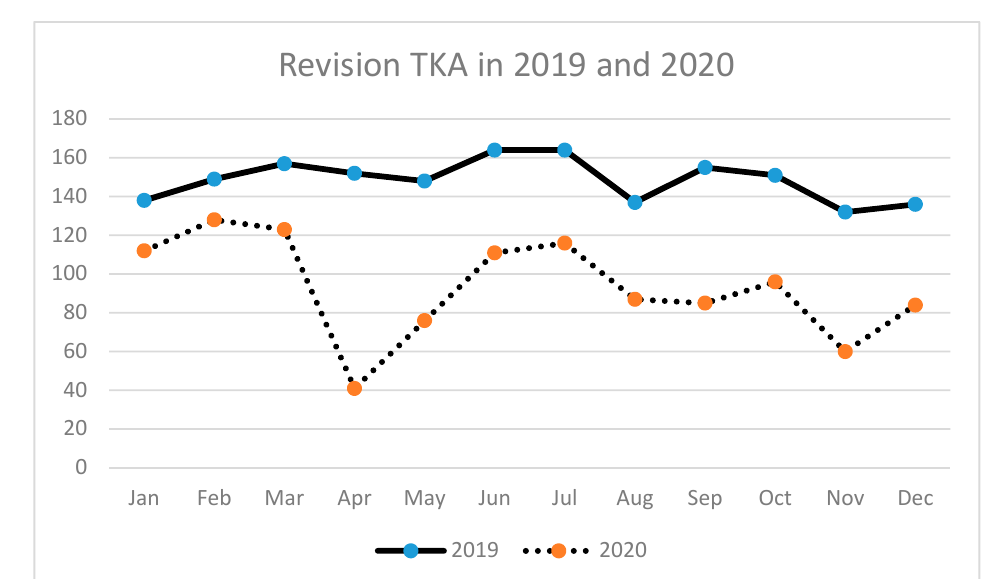
Figure 7. Number of revision total knee arthroplasties (TKA) performed in the particular months of 2019 and 2020 in Poland.